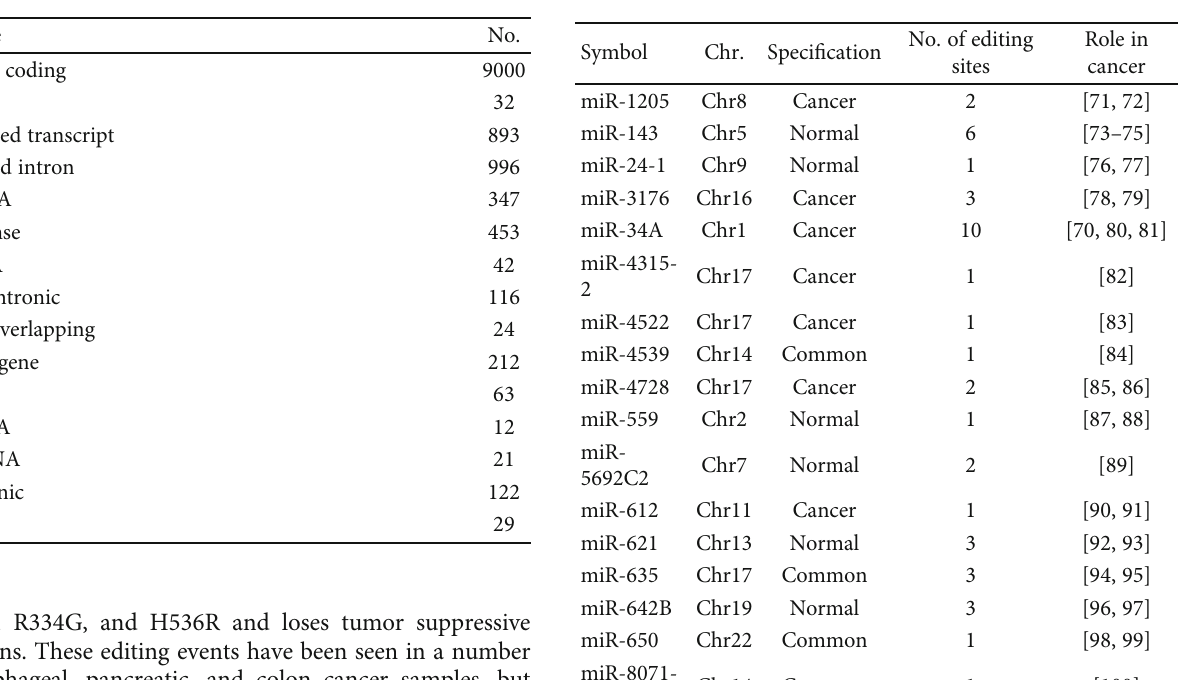
Figure 7: Average editing level in six editing loci of NOP14. Table 2: List of edited microRNAs in gastric cancer and normal Table 1: Number of di ff erent edited biotypes.